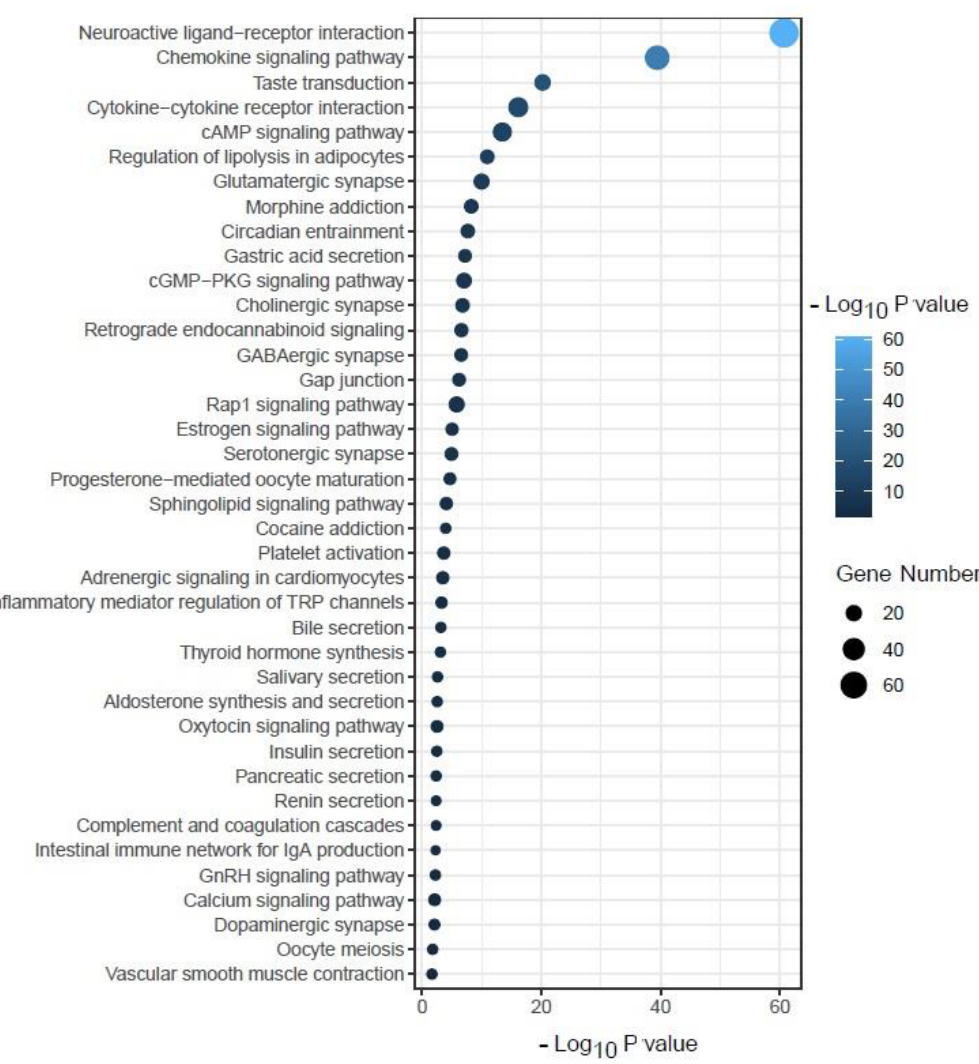
Figure 10. Some of the enriched KEGG pathways significantly associated with target proteins.